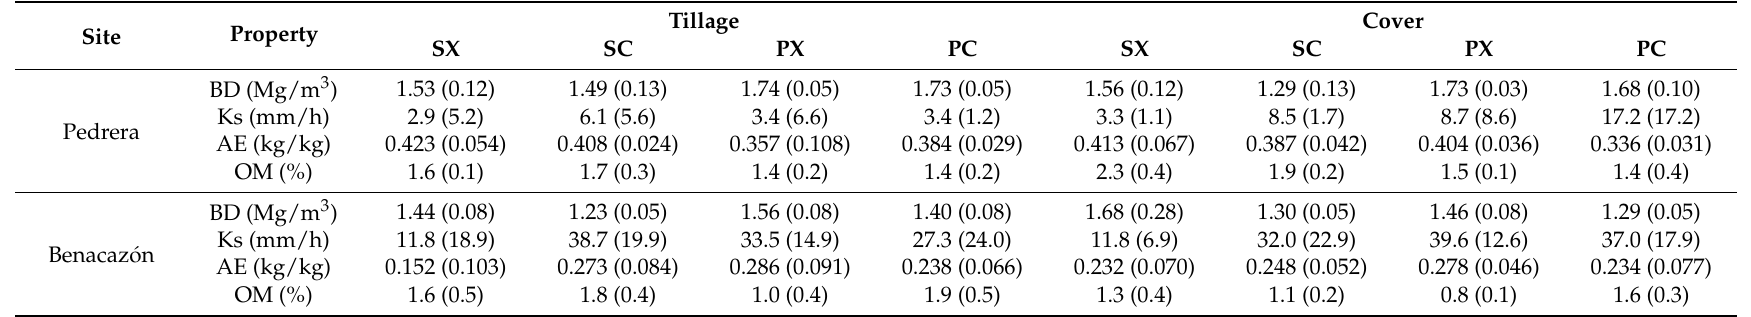
Table 1. Average values and standard deviation (in brackets) at the two sites (Pedrera and Benacaz ó n) and managements (tillage and cover) for the different areas: SX (0–10 cm inter tree row), PX (10–20 cm inter tree row), SC (0–10 cm under tree canopies) and PC (10–20 cm under tree canopies). Soil properties are bulk density